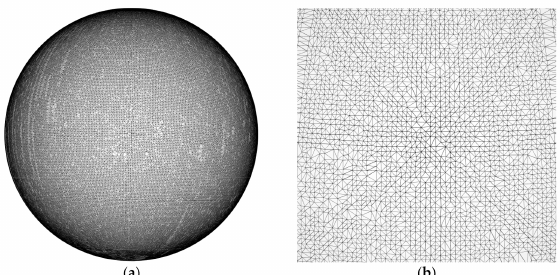
Figure 5. Spherical Delaunay triangulation result. ( a ) Global spherical Delaunay triangulation based on control points from experiment 1; ( b ) enlarged view of the spherical Delaunay triangulation of ( a ) centered at (45 ◦ E, 15 ◦ N) and a window size of 30 ◦ × 30 ◦ .